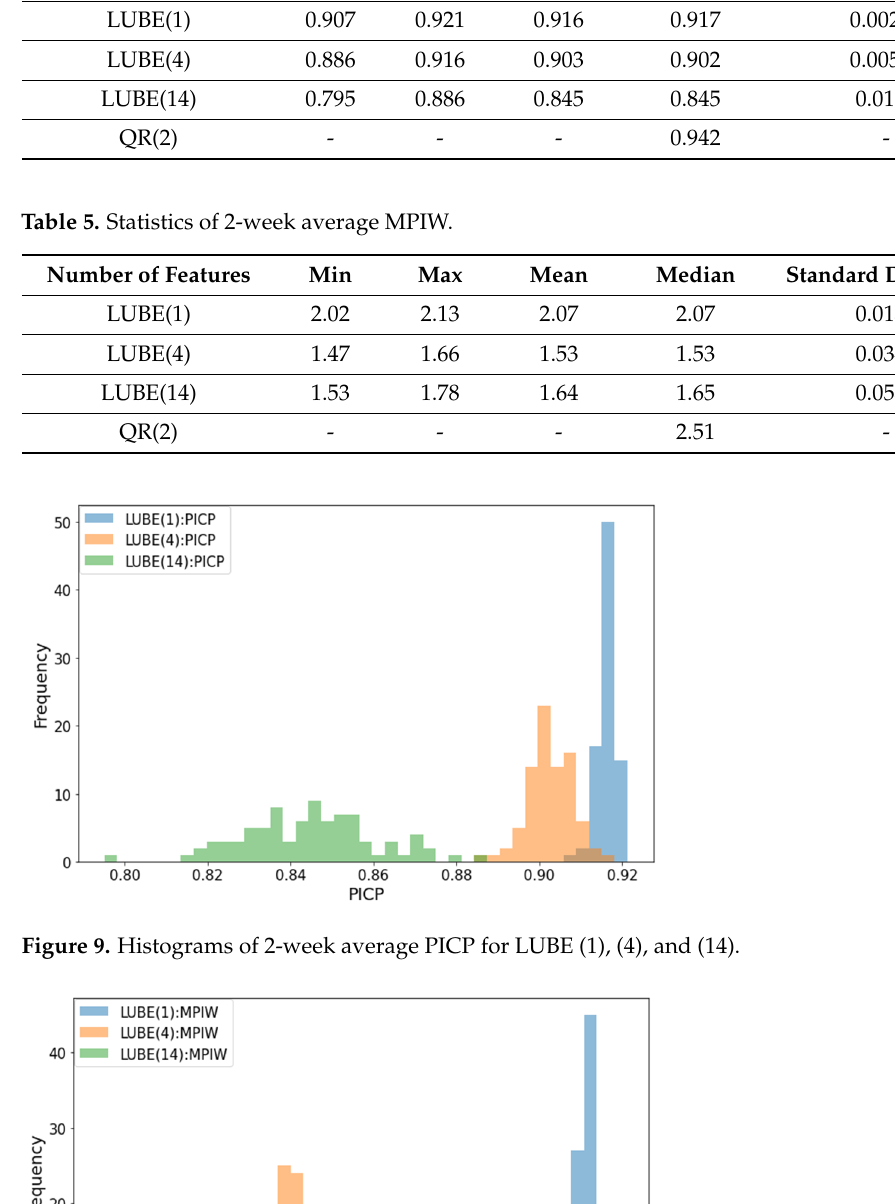
Table 5. Statistics of 2-week average MPIW. Number of